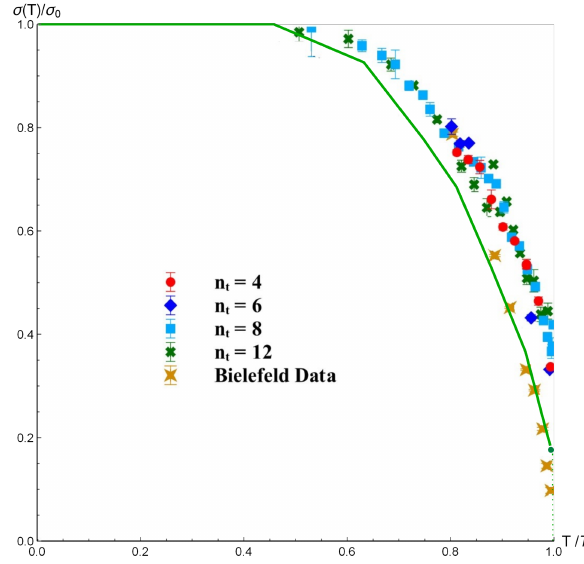
Figure 16 . The green curve shows the string tension as function of temperature for z 0 = 10 exp( − z h / 4) + 0 . 1 , µ = 0 , ν = 1 , a = 4 . 046 , b = 0 . 01613 , c = 0 . 227 . The dots with differ- ent decorations show results of lattice calculations obtained in [47]. The thin green dotted line shows the WL phase transition.